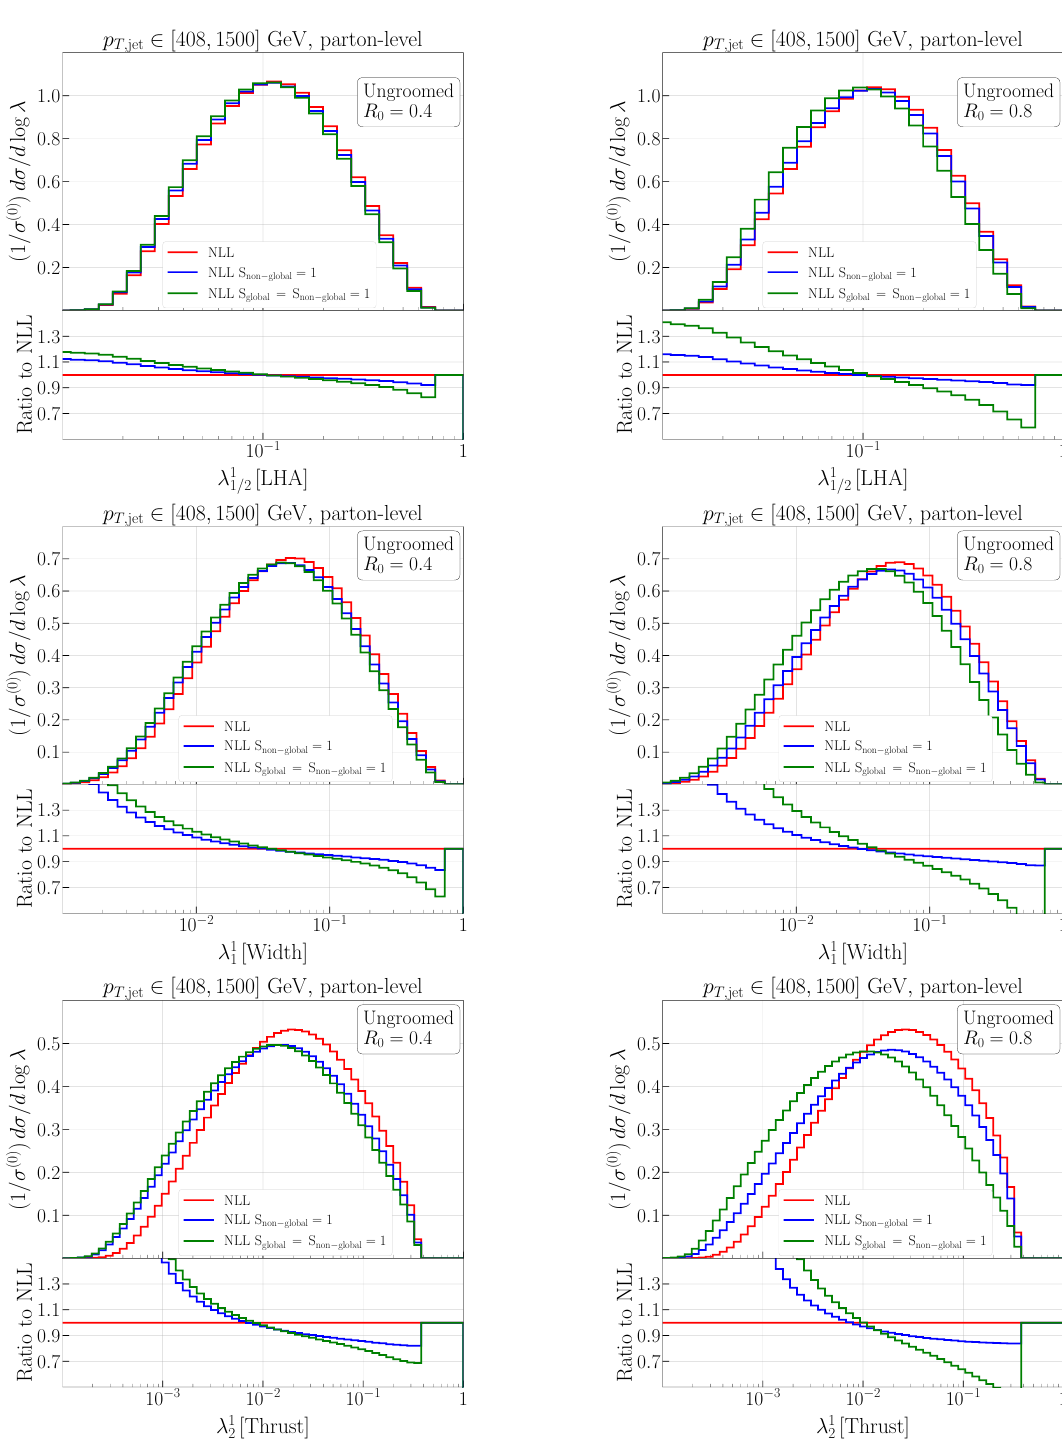
Figure 4 . Anatomy of the soft structure of the NLL predictions for angularities λ 1 { 1 / 2 , 1 , 2 } (top to bottom), for jet radius R 0 = 0 . 4 (left) and R 0 = 0 . 8 (right), with p T, jet ∈ [408 , 1500] GeV. Besides the full NLL distribution (red) variants obtained by either excluding the non-global soft contribution ( S non-global = 1 , blue) or the entire soft contributions ( S global = S non-global = 1 , green) are